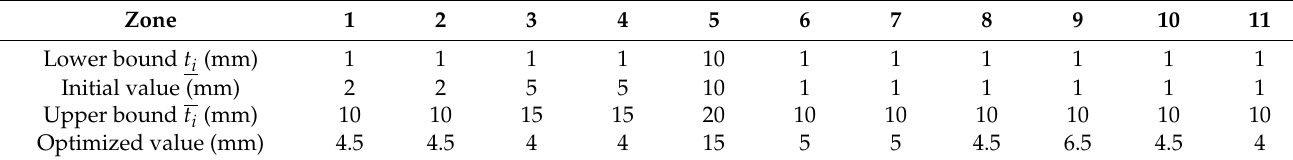
Table 1. Design variables in size optimization.